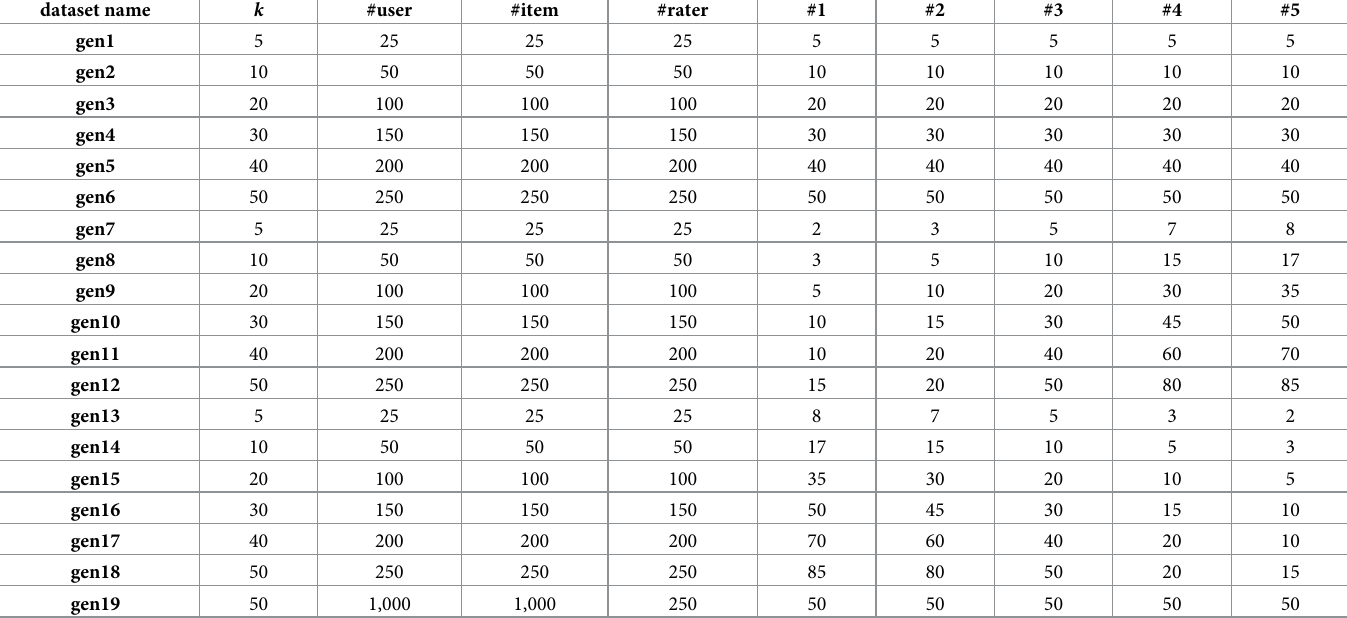
Table 9. The parameters of simulating